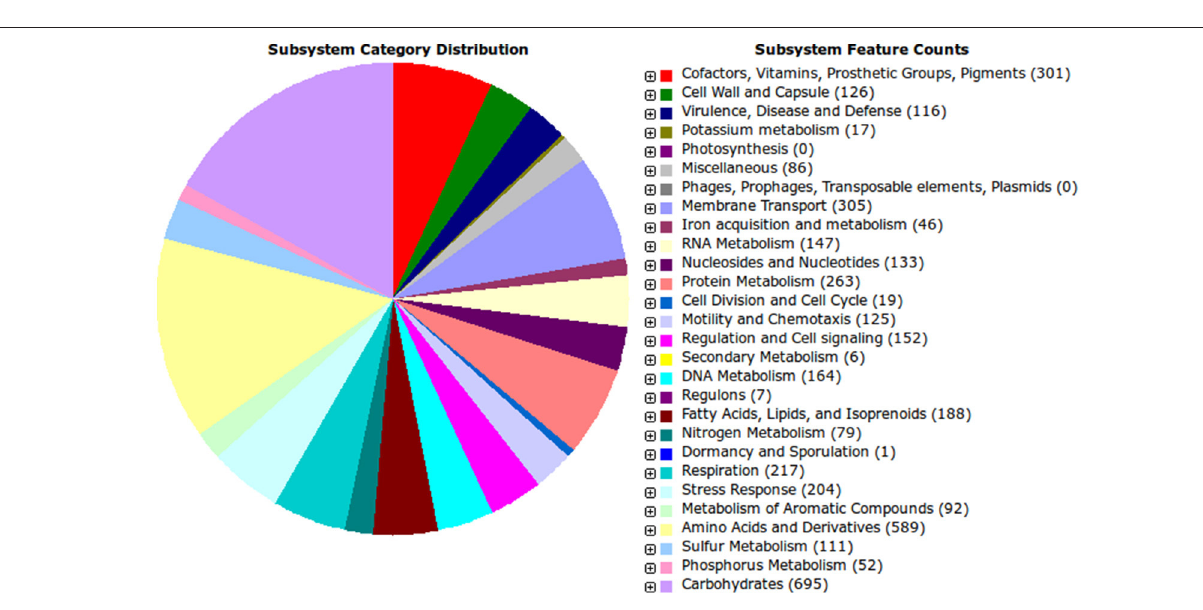
An integral membrane protein, YggT, involved in response to extracytoplasmic stress (osmotic shock) is present, but this gene appears to be widespread among bacteria,